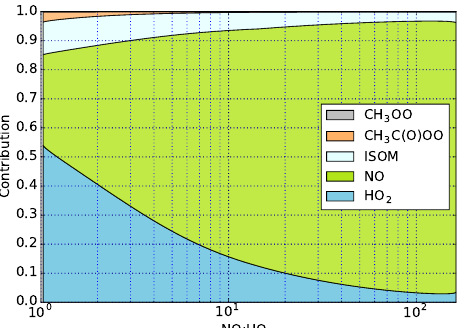
Figure 7. Relative contributions of different reaction pathways to the fate of ISOPOO radicals under different NO:HO 2 . ISOM in- dicates isomerization. Data are from the MXLCH complex scheme =± 30pptvms − 1 and Yield = 6%. Figure 8. Diurnal evolutions of isoprene nitrates (ISOPN), iso- with F NO ISOPN x prene hydroxy hydroperoxides (ISOPOOH), isoprene (ISOP), and NO:HO 2 from the MXLCH complex scheme with =± 30pptvms − 1 and Yield = F NO ISOPN x